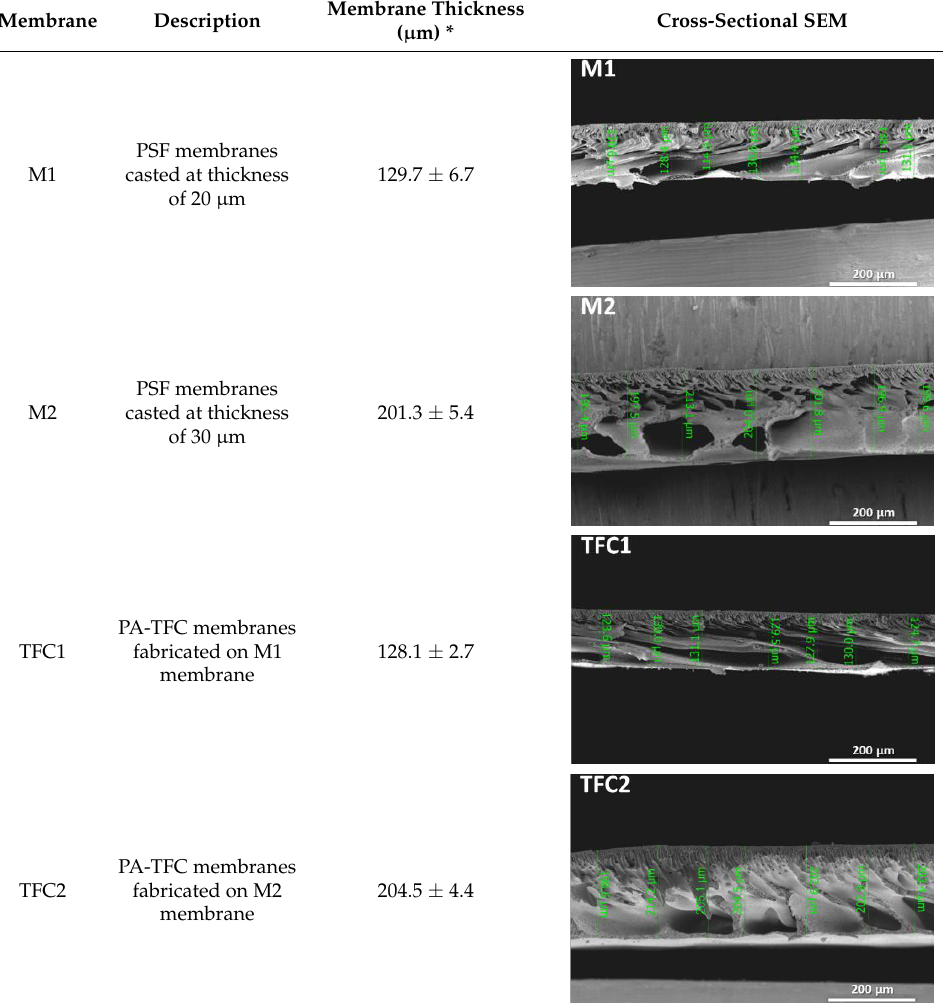
Figure 2. Schematic illustration for the phase inversion and interfacial polymerization approaches used for the TFC membranes fabrication. Table 1. PSF and TFC prepared membrane layers used in this work.